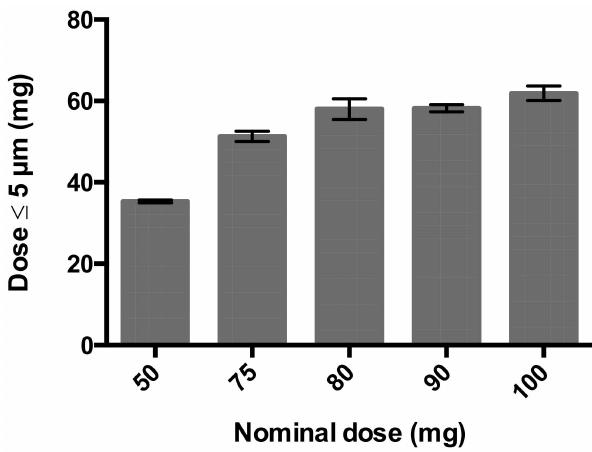
Figure 10. Fine particle dose from the Cyclops ® DPI loaded with di ff erent nominal doses of the 3% trileucine formulation and dispersed at a pressure drop of 4 kPa ( n = 3, average ± SD). The nominal dose refers to the formulation (e.g., the nominal dose of 100 mg contains 97 mg isoniazid and 3 mg trileucine). The fine particle dose is calculated by multiplying the FPF with the emitted mass ( = FPF * (1 –